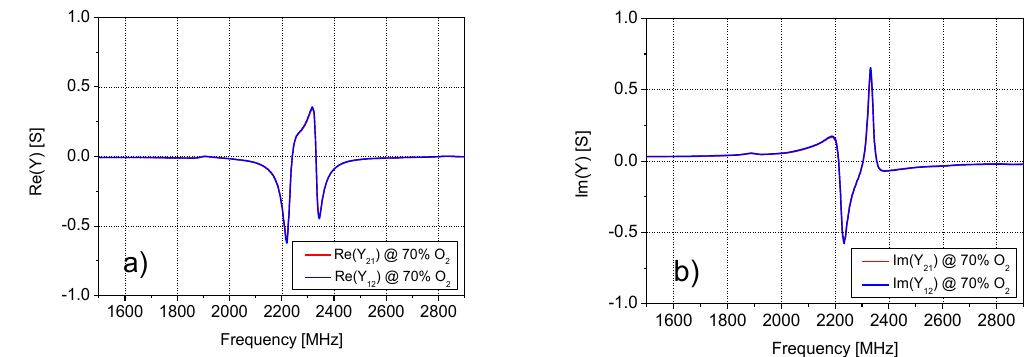
Figure 6. Frequency dependence of the ( a ) real and ( b ) imaginary parts of the admittance parameters Y 11 and Y 22 at 70% of O 2 concentration.